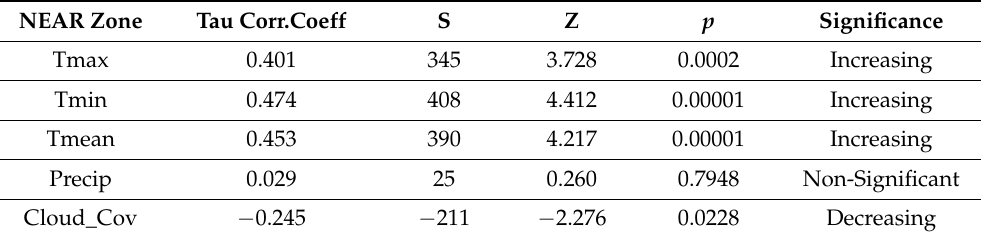
Table 7. Mann Kendall Trend Test of JJAS averaged climatic variable for NEAR zone.